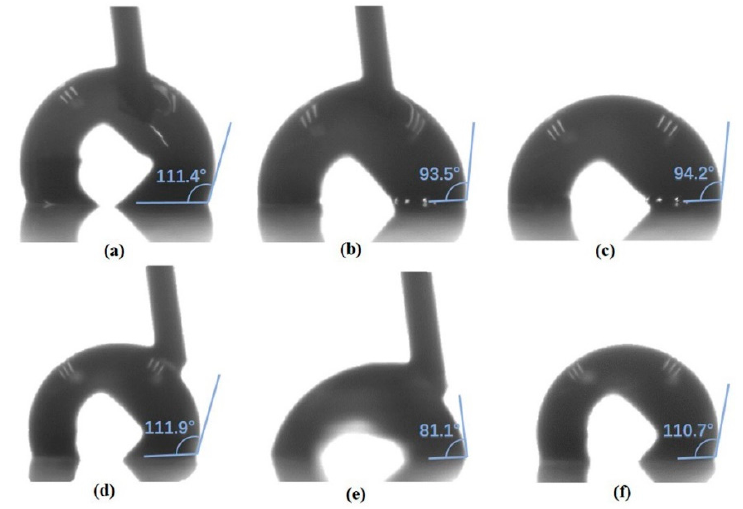
Figure 5. AC static electrowetting test in the air under ( a ) AC off ( b ) 44V rms ( c ) AC off again, and in the “air after oil” under ( d ) AC off ( e ) 44V rms ( f ) AC off again.